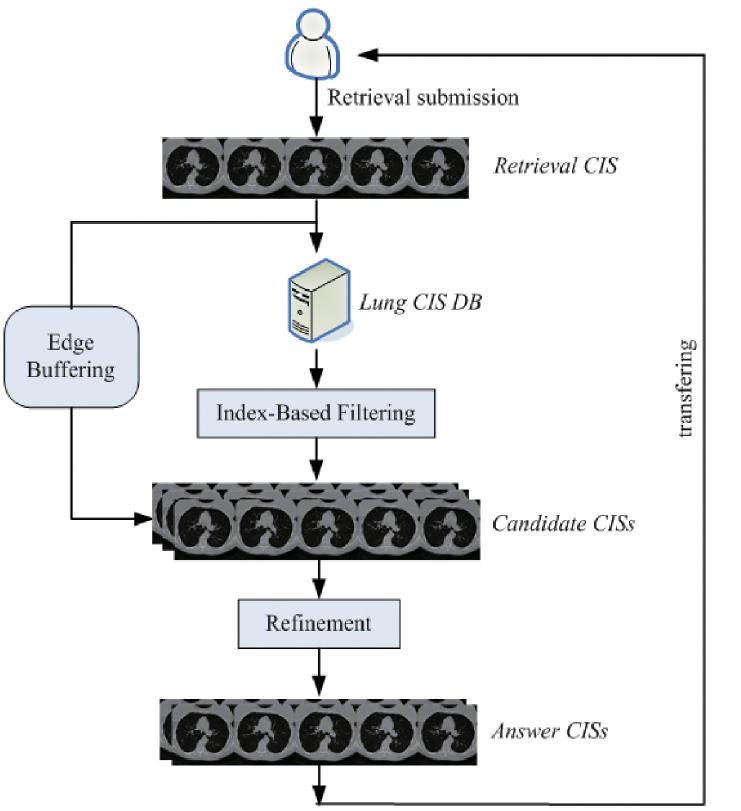
Fig 9. An example of the BRS